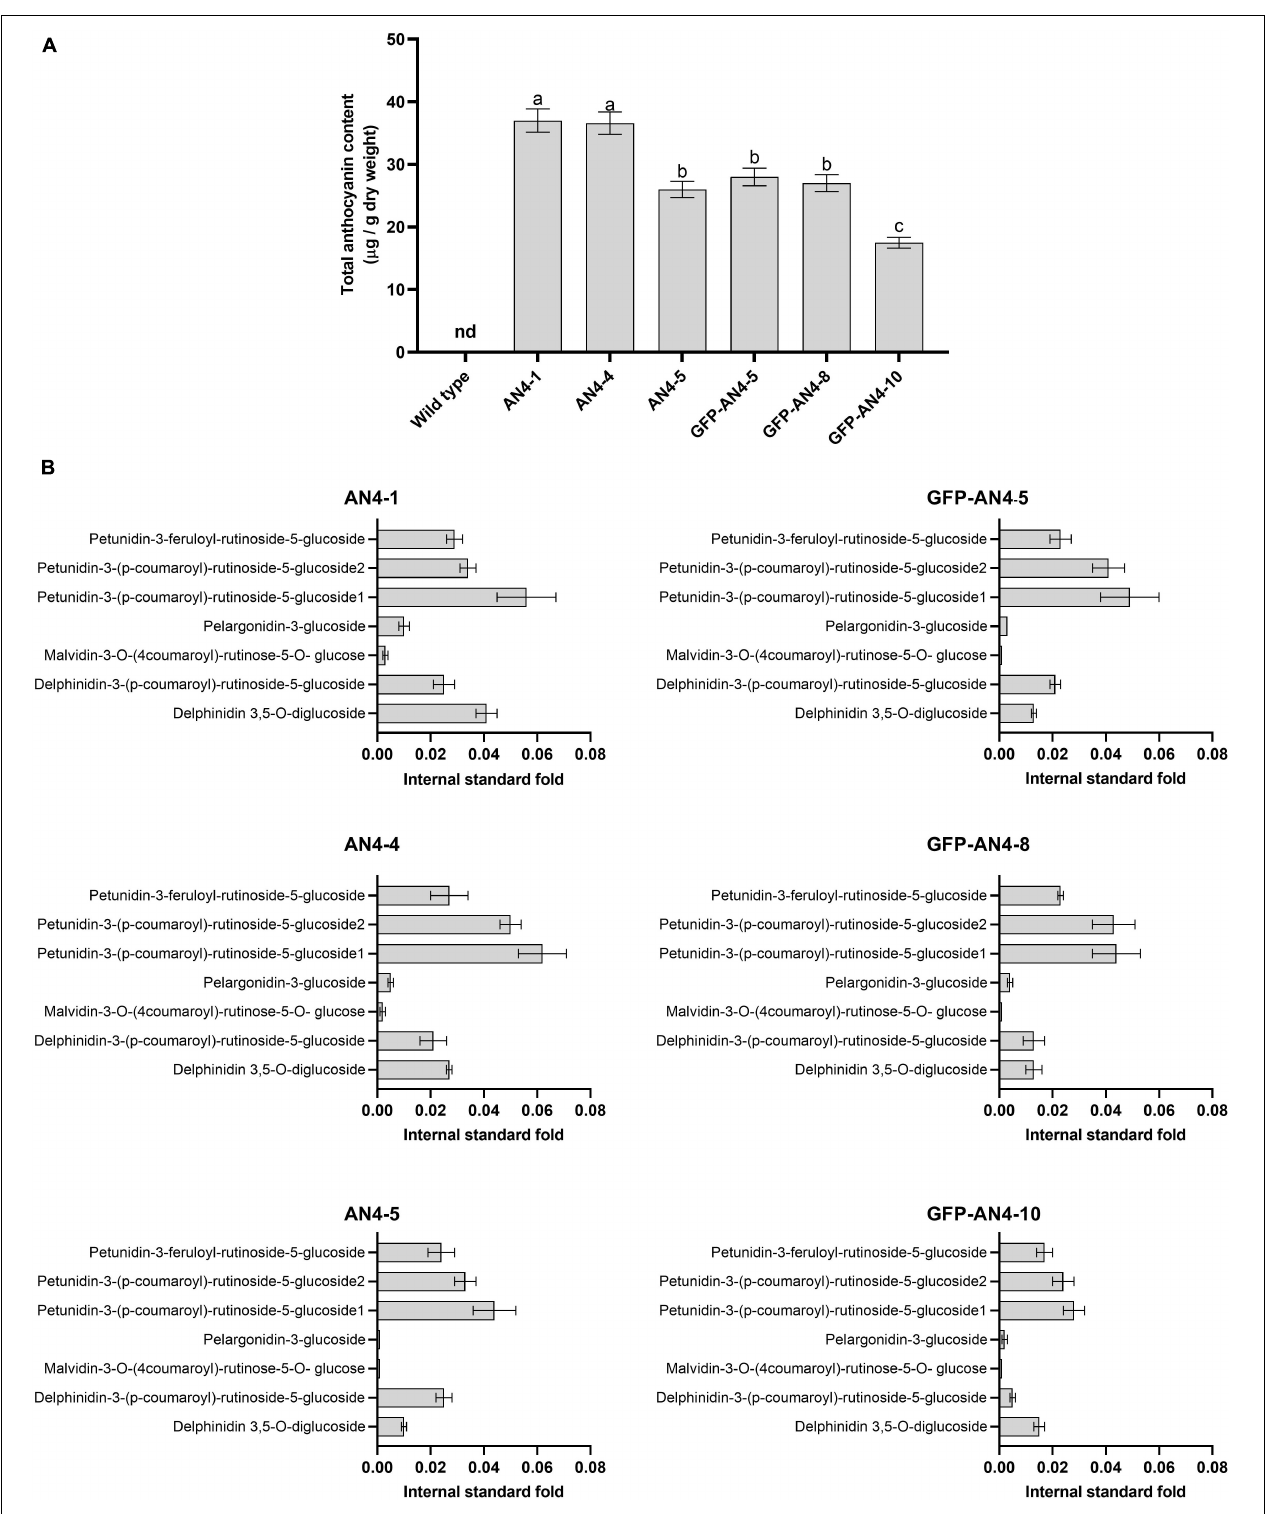
FIGURE 2 | Anthocyanins in PhAN4 HRC clones. Total anthocyanins content (A) and amount of specific anthocyanins (B) of six representative PhAN4-expressing hairy root clones. Columns report average values ± SD ( n = 3).